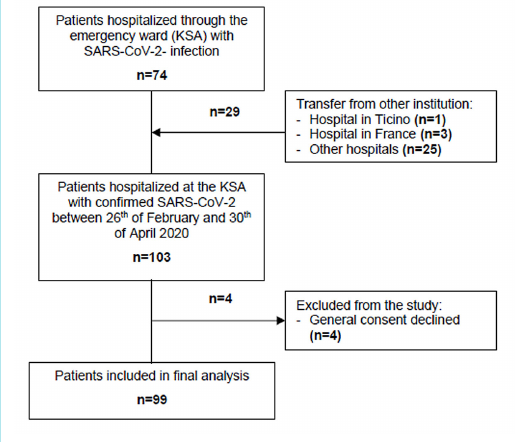
Figure 1: Flow chart of the study. KSA = Cantonal Hospital Aarau; SARS-Cov-2 = severe acute respiratory syndrome coronavirus